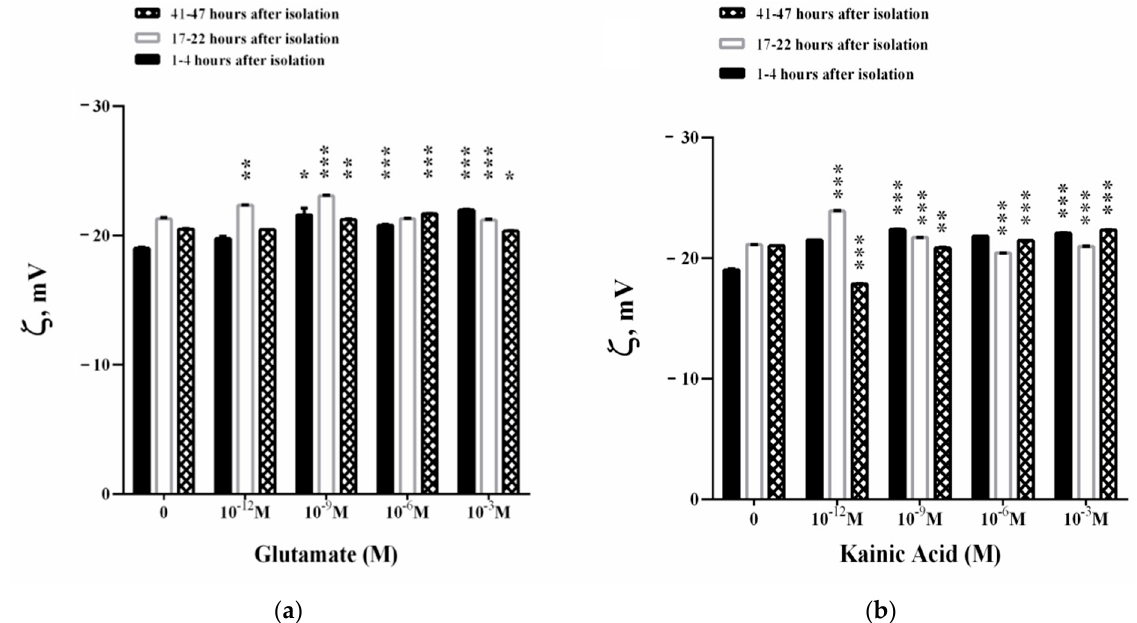
Figure 5. Zeta potential ( ζ ) of synaptosomes from the cerebral cortex after treatment with ( a ) L-glutamate and ( b ) kainic acid. Synaptosomes are treated for 30 min at 37 °C. Zeta potential measurements are performed at 25 ± 0.1 °C in 0.05 M Tris-HCl buffer, pH 7.2. Each value is the mean ± SE of three independent preparations. * p < 0.05; ** p < 0.01; *** p < 0.001.